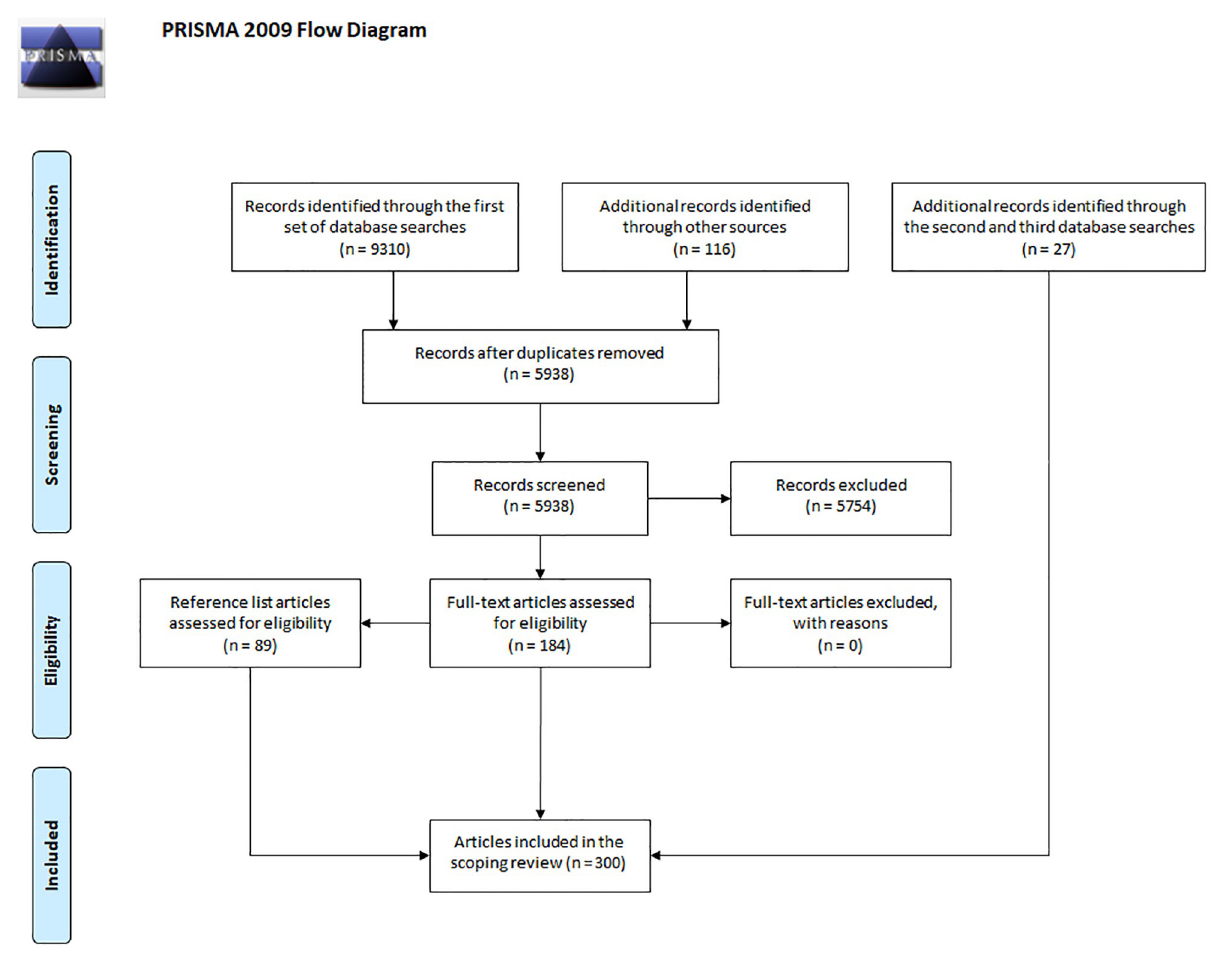
Fig 1. PRISMA-ScR flow-chart.